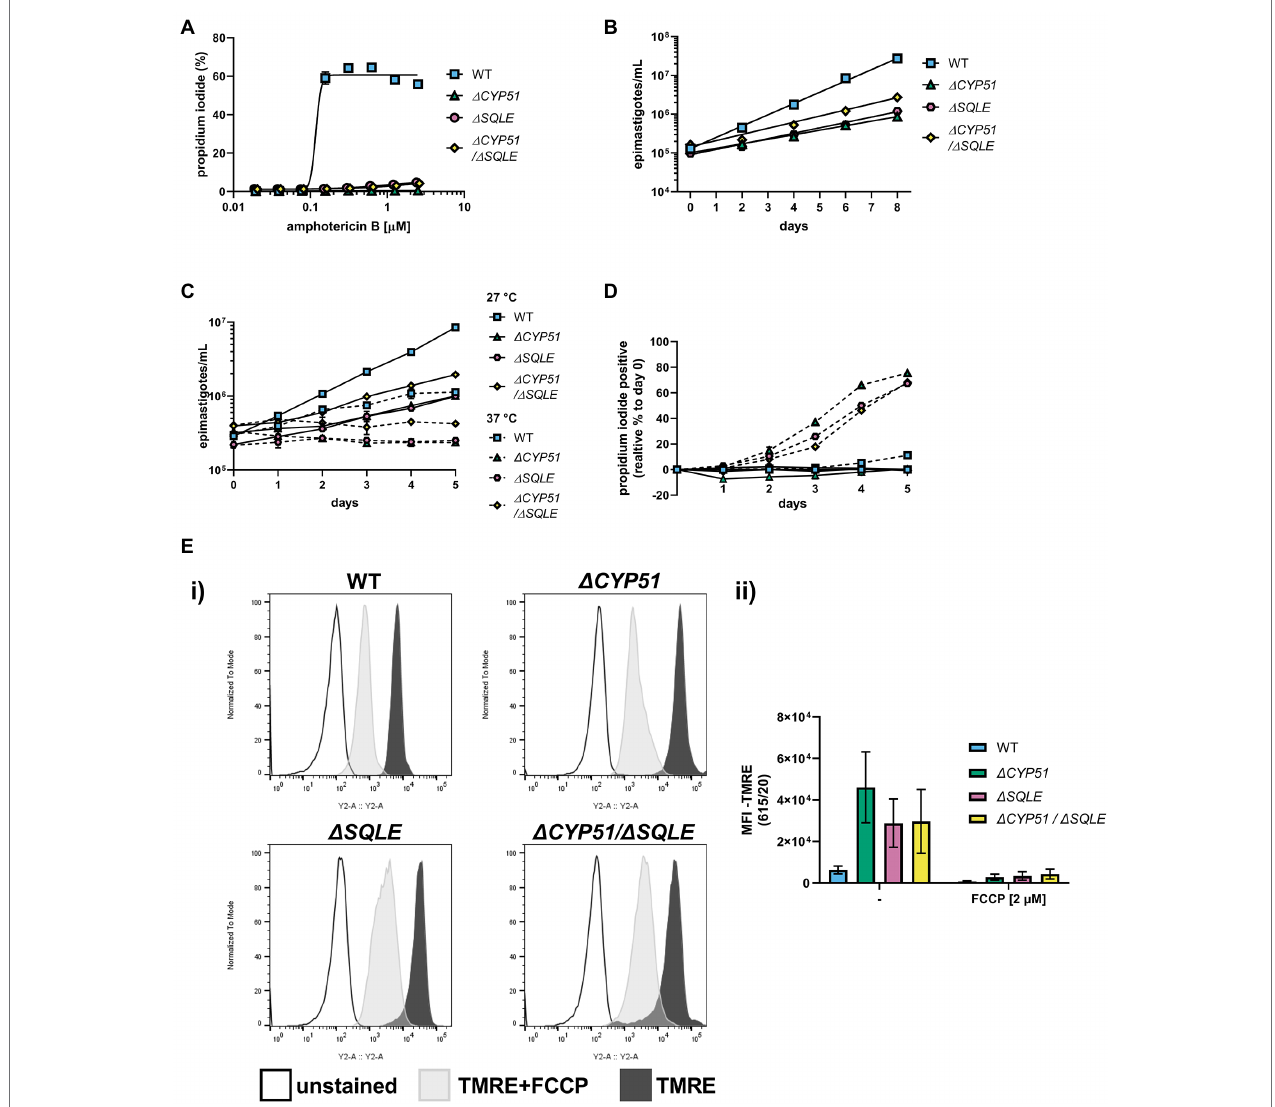
FIGURE 7 | (A) Measurement of epimastigote membrane integrity by flow cytometry using propidium iodide staining following incubation for 4 h with the indicated concentrations of amphotericin B (n = 3), mean ± SD shown. (B) Measurement of epimastigote concentration every 48 h starting at 1e5 epimastigotes/ml (n = 3), mean ± SD shown. (C) Growth and (D) membrane integrity of epimastigotes assessed daily during continuous exposure to either 27 ° C or 37 ° C (n = 3), mean ± SD shown. (E) (i) Flow cytometry histograms of parasite fluorescence in the Y2 (615/20) channel. Unstained controls are shown along with TMRE stained parasites. (ii) Mean fluorescence intensity (MFI) in the Y2 channel with and without pre-treatment of parasites with FCCP ±SD shown. Parasite line, FCCP treatment and interaction have p < 0.001 by two-way ANOVA; all multiple pairwise comparisons compared to WT are significant after Bonferroni